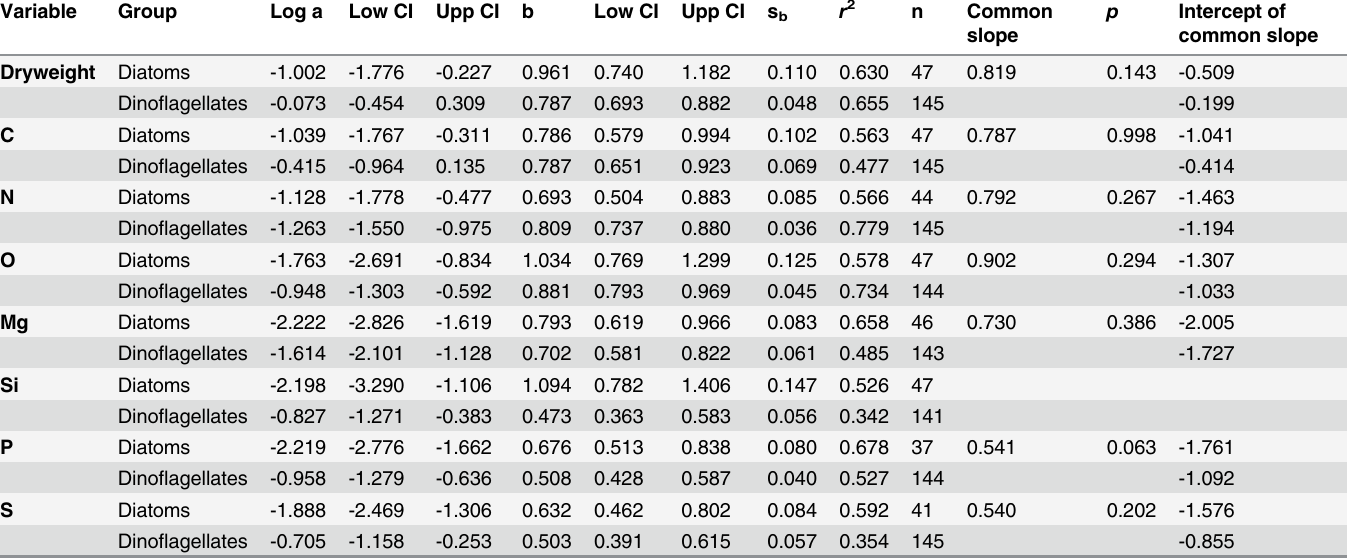
Shown in this table are the y-intercept (log a) and the slope (b) of the regression equations, the interval of con fi dence (Low CI and Upp CI), the standard error of the slope ( s b ), the coef fi cient of determination ( r 2 ), the number of data points included (n), the common slope (when there are no signi fi cant differences between the slope of both groups), its p -value, and the intercept of each group with the common slope. The elemental quota can be determined from volume based on the equation log 10 element (pg cell -1 ) = log a + b x log 10 volume ( μ m 3 ). Same element slopes of diatoms and dino fl agellates are not statistically different, except for Si ( p = 0.002). The intercepts of the dino fl agellates regression lines are larger than those of diatoms for the same element, except for N ( p (cid:1) 0.001). However, this difference disappears when the common slope is